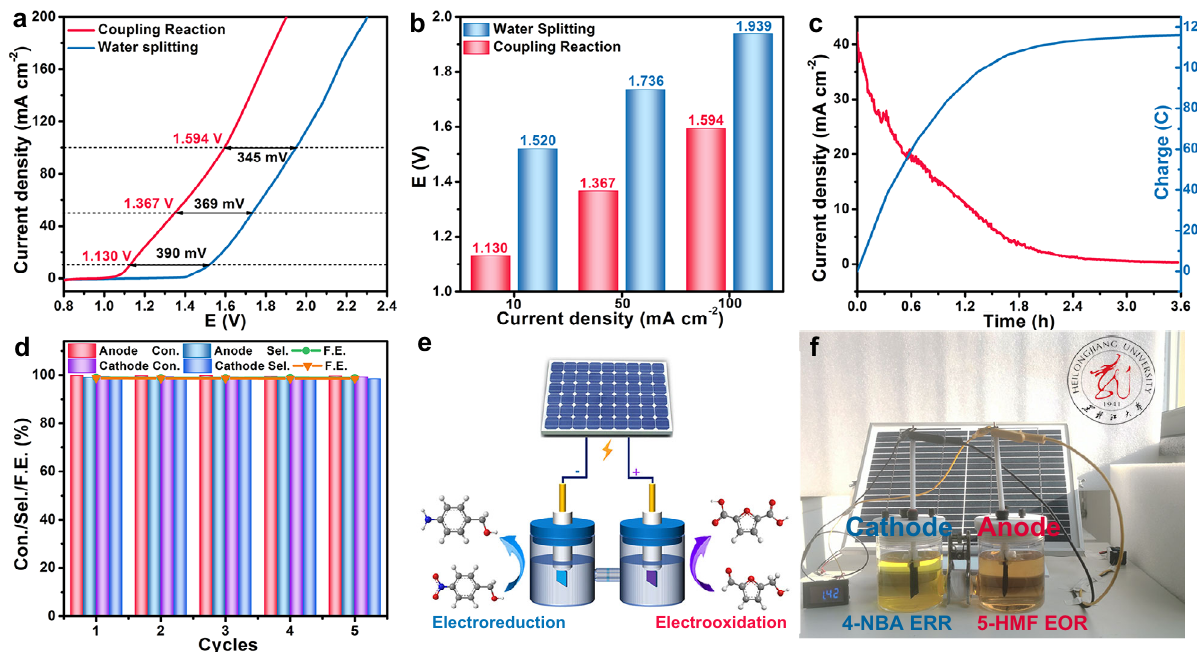
Fig. 5 Paired electrocatalysis of 4-NBA ERR and 5-HMF EOR. a LSV curves and b comparison of potentials of FeP-MoP/FF | | FeP-NiMoP 2 /FNF couple with and without organic substances. c Chronoamperometric response curve. at 1.404 V. d The conversion, selectivity and FE of anode and cathode during the coupling reaction for fi ve successful cycles. e Illustration of the paired electrocatalysis system driven by solar-cell. f Demonstration of pairing 4-NBA ERR (left) and 5-HMF EOR (right) in H-type cell by using a solar-driven system with a voltage of 1.420